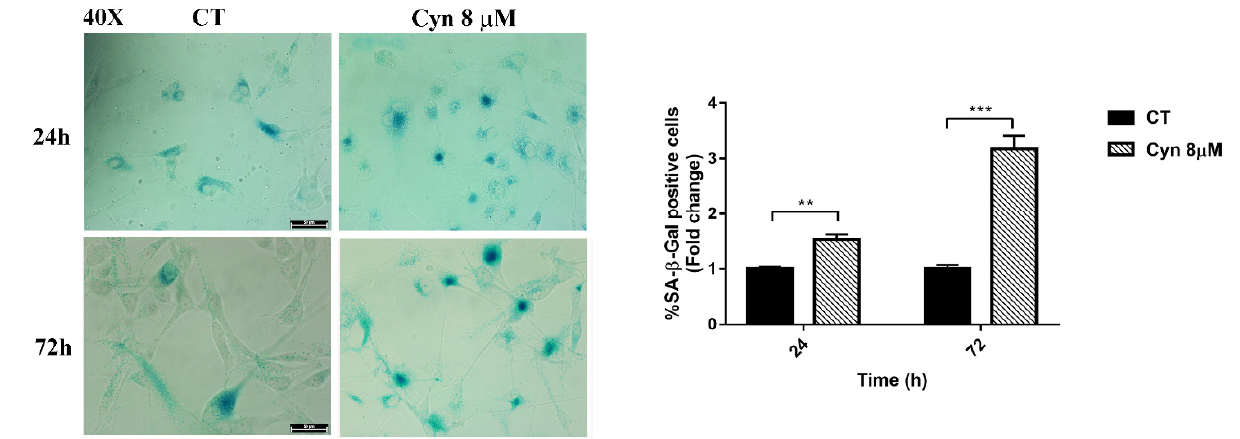
Figure 5. Activation of senescence in U87MG under chronic treatment with Cyn. Change in the SA- β -gal activity in U87MG cells treated daily with Cyn 8 µ M for 24 and 72 h was reported as a percentage increase. Cells were microscopically evaluated, and the number of SA- β -Gal-positive cells versus the number of total cells was counted at 40 × magnification. The results are expressed as a fold change over control-treated cells. Statistical analysis was performed with the Student’s t -test, p -value < 0.05. According to GraphPad Prim 7 software, a ** p -value from 0.001 to 0.01 was considered very significant and *** a p -value from 0.0001 to 0.001 was extremely significant.